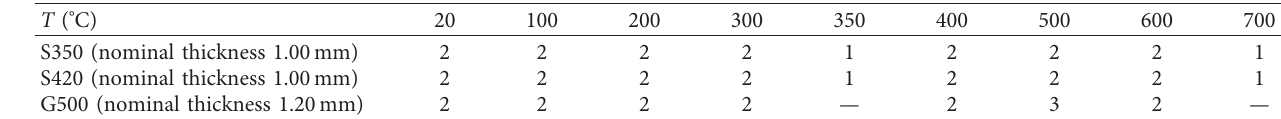
Figure 6: High-temperature extensometer system. Table 3: Number of tests performed in this